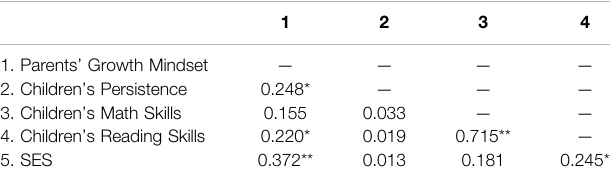
TABLE 3 | Bivariate Pearson correlation results between study